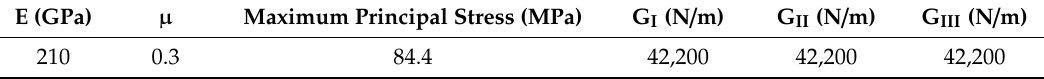
Figure 2. Rectangular plate with a horizontal crack. Table 1. Material properties of the rectangular plate.